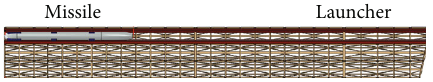
Figure 9: Launching platform and missile.